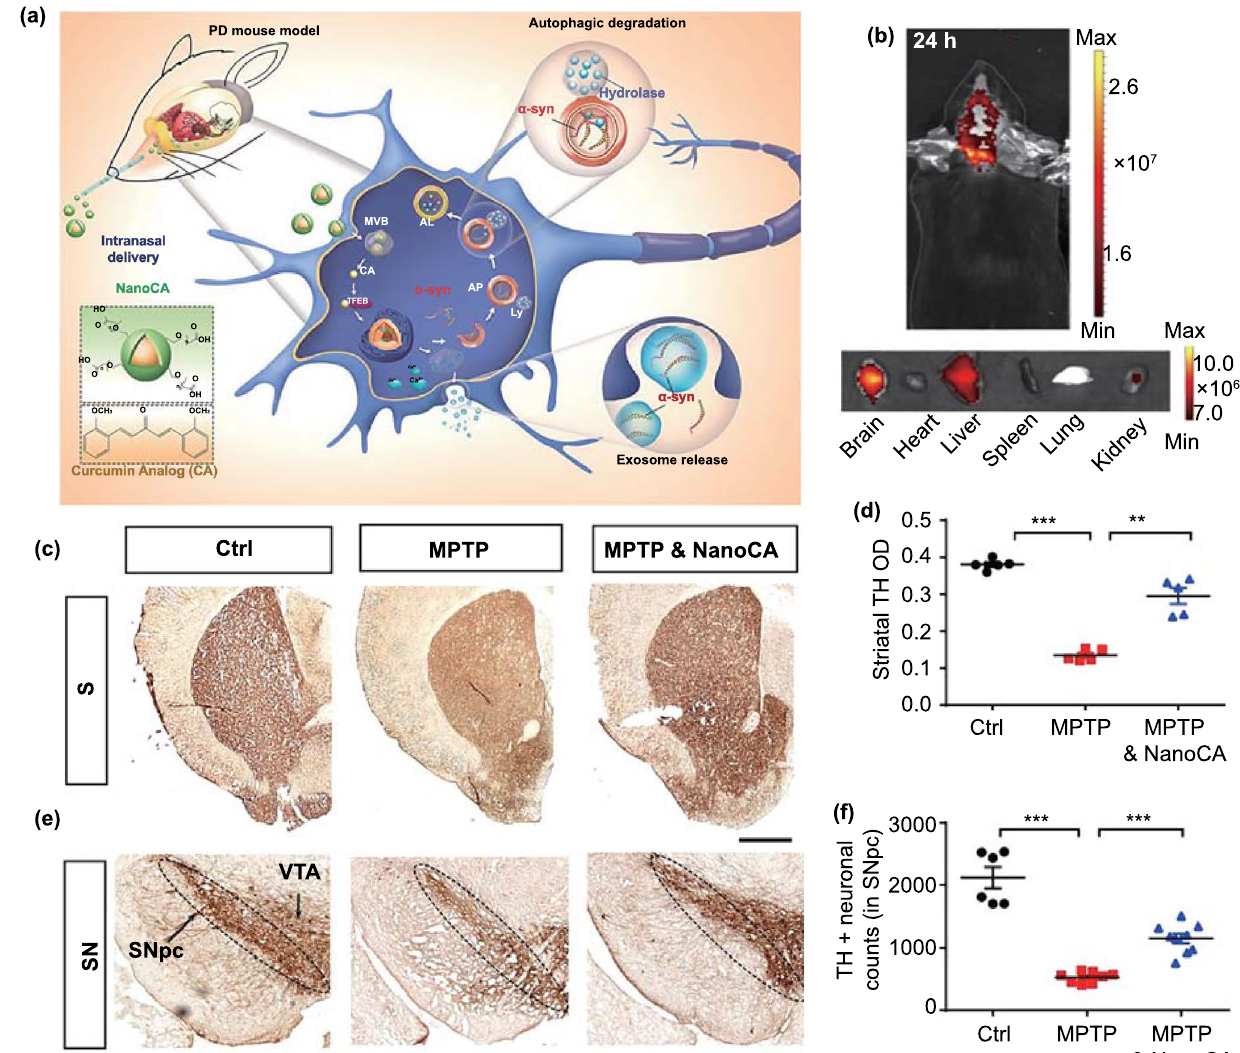
Fig. 5 Example of nasal delivery. a Design of self-assembled NanoCA NPs for TFEB-regulated cellular clearance of α -syn in experimental models of PD. b Representative IVIS images showing the biodistribution of NanoCA@TPAAQ in mice after intranasal administration. c Repre- sentative photomicrographs of striatal TH immunostaining from the same animals. d Quantification of TH immunoreactivity in the striatum. TH immunoreactivity in midbrain sections from the same animals. f Quantification of surviving TH + dopaminergic neurons in the SN. Adapted